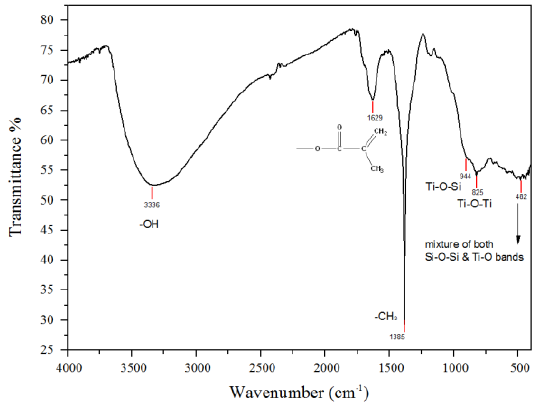
Figure 2. Fourier transform infrared spectra (FTIR) of Ti–O–Si-organic precursor sols.